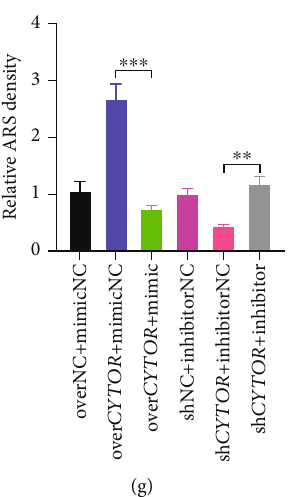
Figure 3: CYTOR facilitates osteogenic di ff erentiation of PDLSCs via competitively binding to miR-6512-3p. (a) The miR-6512-3p expression was determined by qRT-PCR after transfection of miR-6512-3p mimic and miR-6512-3p inhibitor, compared with their respective control group. (b, c) The mRNA (b) and protein (c) levels of osteogenic related marker genes ( RUXN2 , Osterix, and OCN ) were detected by western blot in indicated groups. (d, f) ALP staining (d) and ALP activity (f) in PDLSCs of indicated groups and cultured with OM for 7 days. (e) The formation of mineralized nodules was detected by Alizarin Red staining. (g) Semiquanti fi cation of (e). ∗ p < 0 : 05 , ∗∗ p < 0 : 01 , and ∗∗∗ p < 0 : 001 , compared with the group as